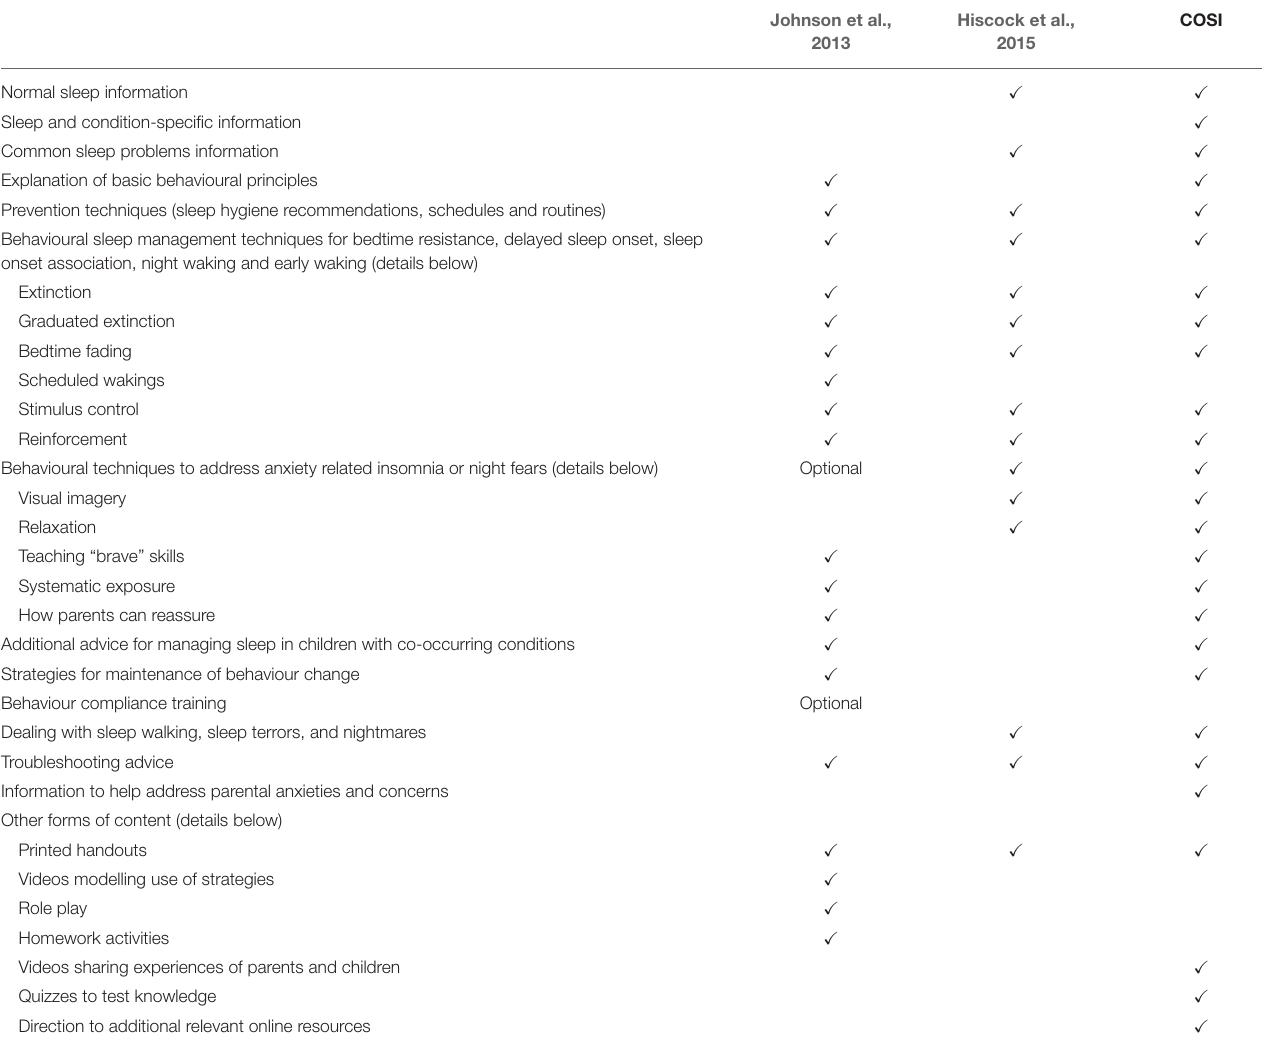
TABLE 1 | Overlap and extension of informational and instructional content from existing BSIs and in